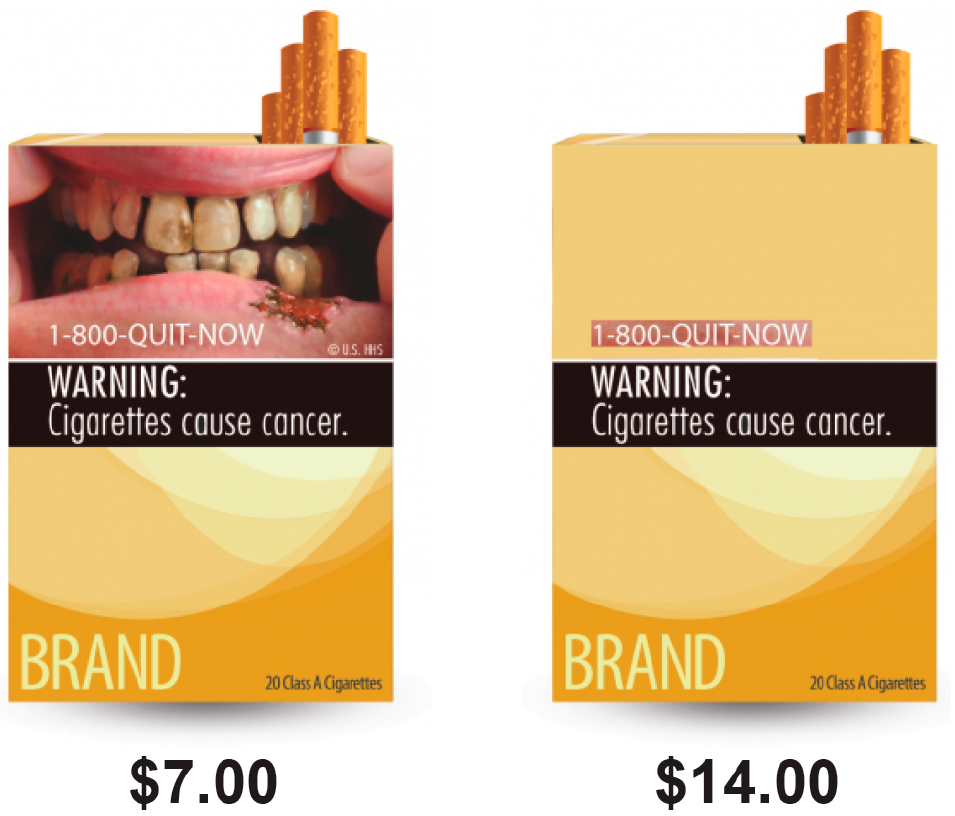
Figure 1. Example question from the hypothetical cigarette valuation task .